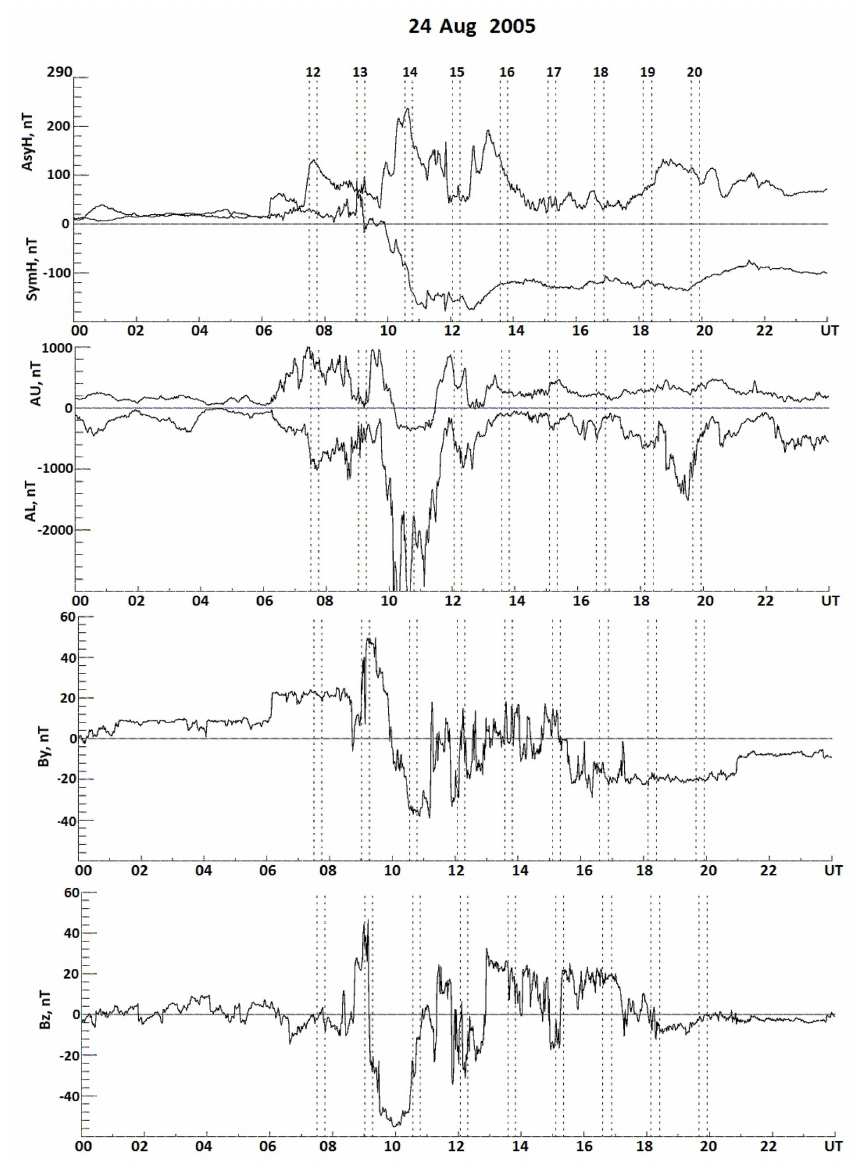
Figure A1. One-minute values of the AsyH, SymH, AU, and AL indices and of the B y and B z components of the IMF for the storm on 24 August 2005 (analysis interval from 07:00–20:00UT, orbits 29012–29020). The time of each orbit and its orbit number are indicated as in Fig. 1 of the